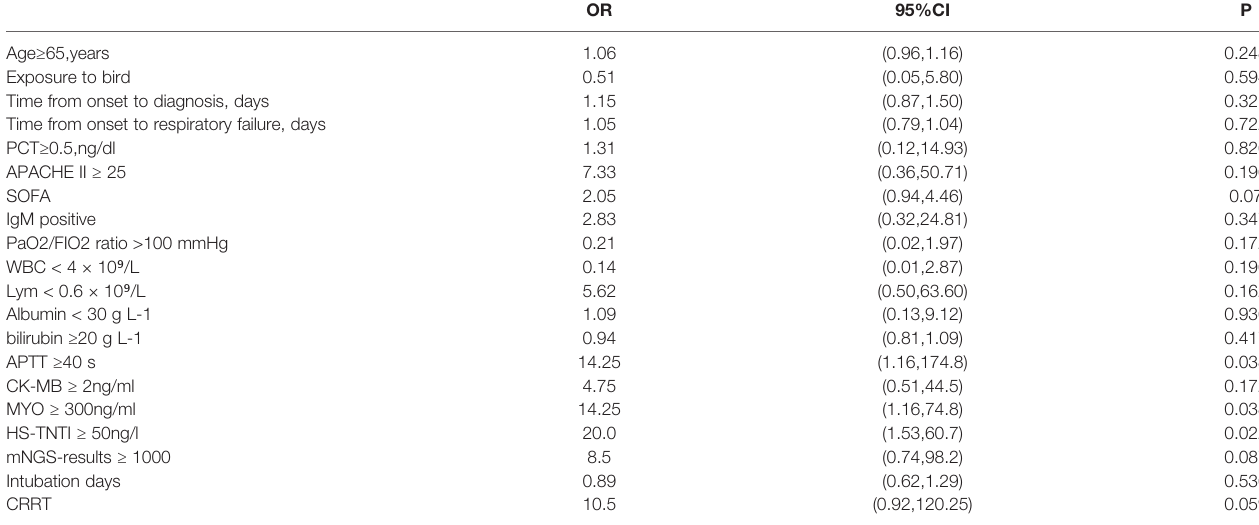
SOFA, Sequential Organ Failure